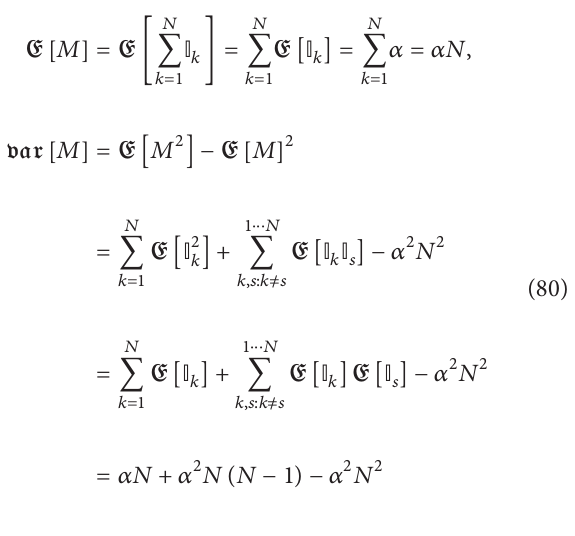
Figure 8: The parameter 𝜅 as a function of 𝛽 . Estimates of 𝜅 are obtained from least-squares fits of data to a linear model 𝑎 = 𝑎 0 +𝜅⋅ V